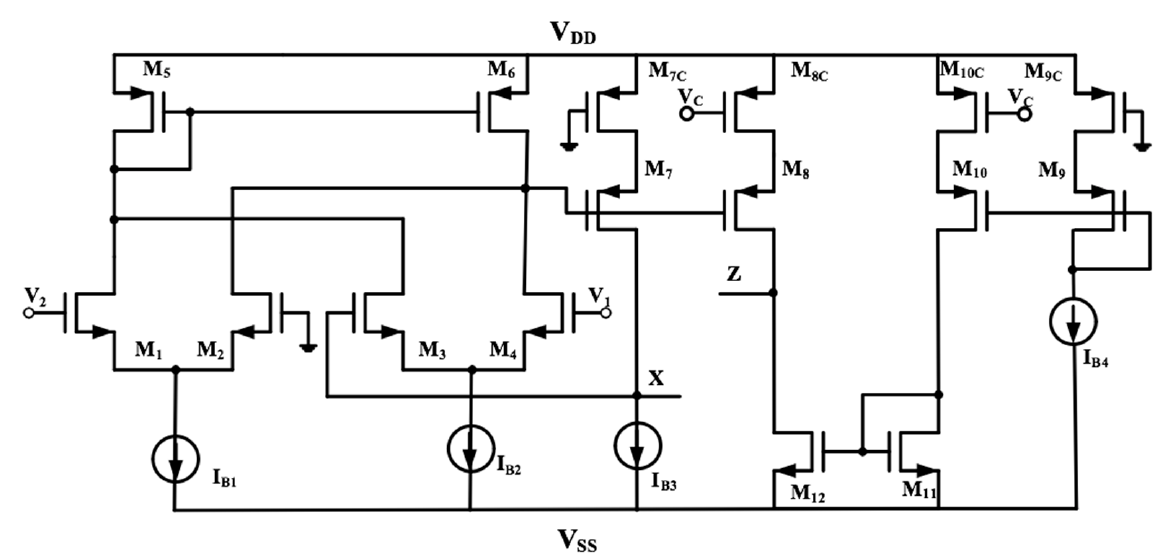
Figure 7. CMOS implementation of E-DVCC.